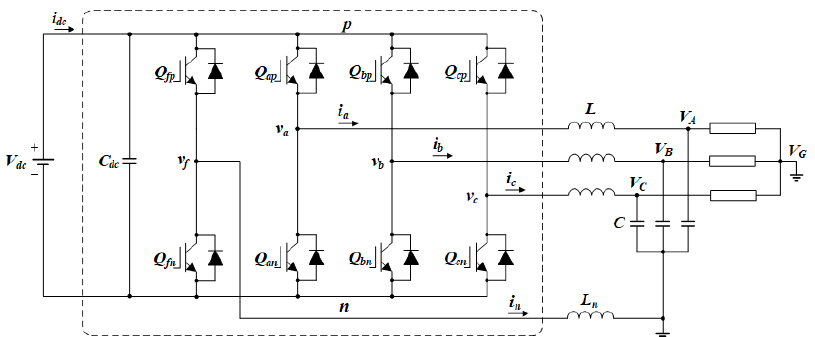
Figure 3. Circuit configuration of three-phase 4-leg inverter.